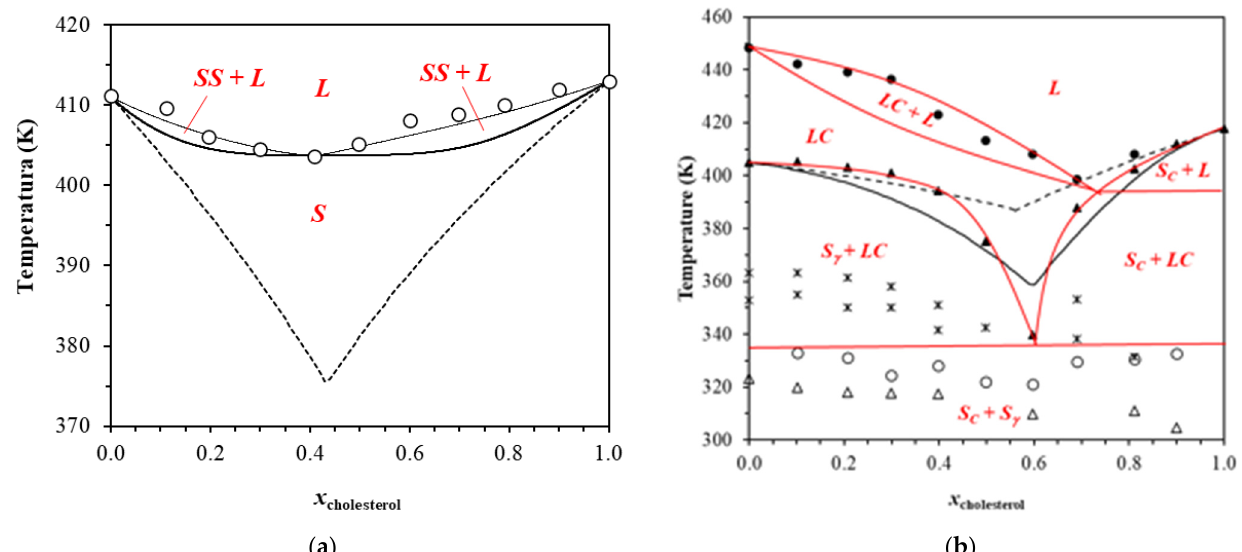
Figure 3. ( a ) SLE diagram for cholesterol + phytosterol; DSC peak top melting temperatures ( ); Equation (1) (continuous lines, solid phase parameters A = 6.5 kJ/mol; B = − 0.3 kJ/mol; liquid phase parameters A = 4.5 kJ/mol; B = − 0.1 kJ/mol); ideal behavior (dashed lines). ( b ) SLE phase diagram for cholesterol + γ -oryzanol: 1st transitions for DSC ( (cid:52) ) and POM ( ), DSC solid transitions ( ∗ ), DSC melting temperatures ( (cid:78) ), Liquid crystal disappearance ( • ). Dashed lines are the ideal behavior; Black lines are Equation (1) considering a simple eutectic profile (Liquid phase parameters A = − 13.1 kJ/mol; B = − 1.9 kJ/mol); Red lines are the possible interpretation of the diagram. L = Liquid Phase; LC = Liquid Crystal; S C = cholesterol solid phase and S g = γ -oryzanol solid